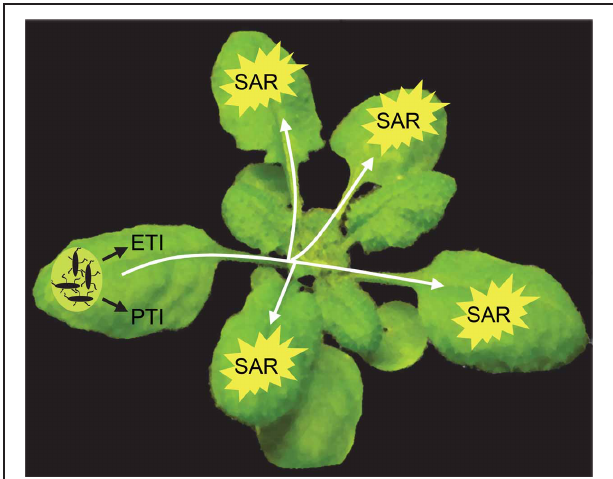
FIGURE 1 | Systemic acquired resistance. Pathogen infection results in the activation of defenses, for example PAMP-triggered immunity (PTI) and effector-triggered immunity (ETI), in the pathogen-infected organ. Simultaneously, the infected organ releases signals that are transported to rest of the foliage, where it induces systemic acquired resistance (SAR), which protects these organs against subsequent infections by a broad-spectrum of pathogens. The phloem is a likely conduit for the transport of these long-distance SAR signals. In the distal organs, effective signal amplification must take place to guarantee SAR